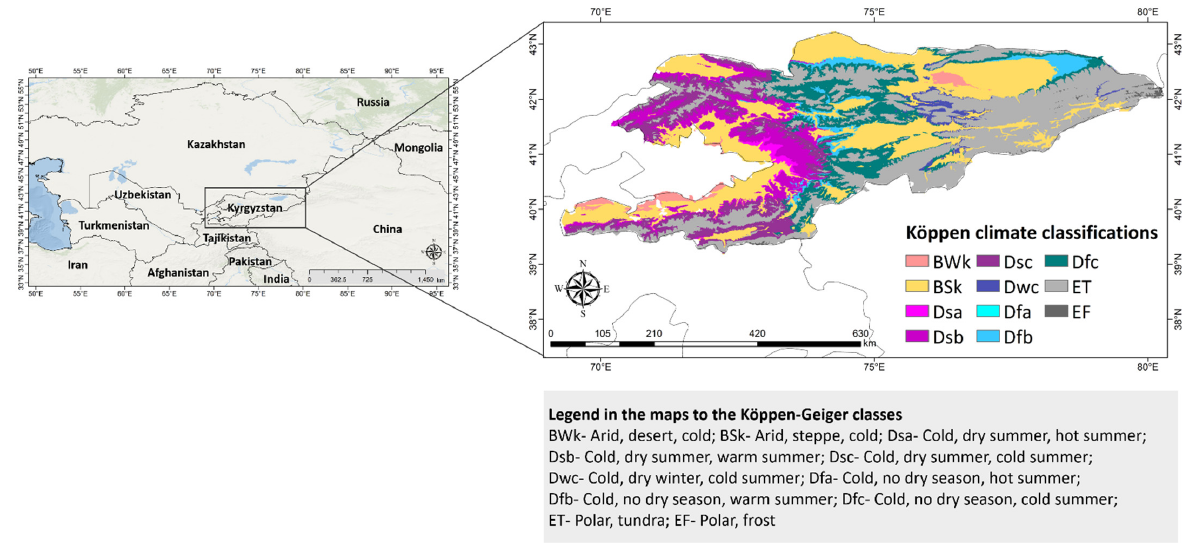
Figure 1. Map of the study area with the locations of Central Asia and Köppen climate classification of